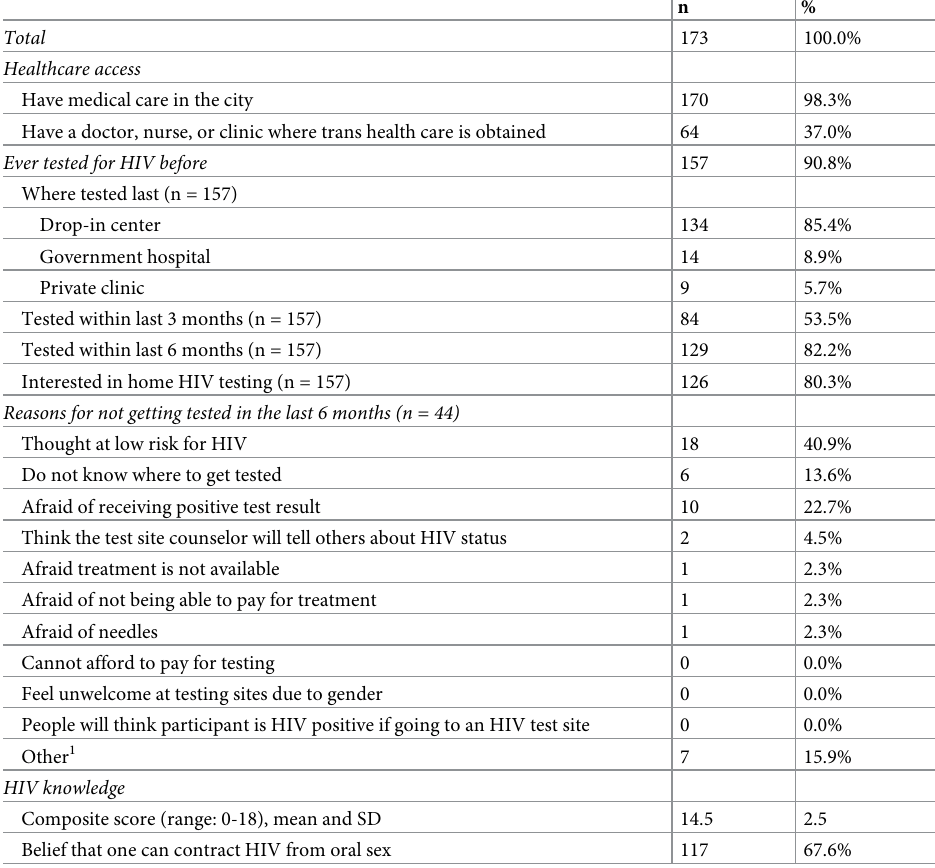
Table 2. Healthcare access, HIV testing behaviors, reasons for not getting tested, and HIV knowledge reported by HIV-negative trans women, Tesoro Lingi, and people with other genders in Nepal, 2019 (n =